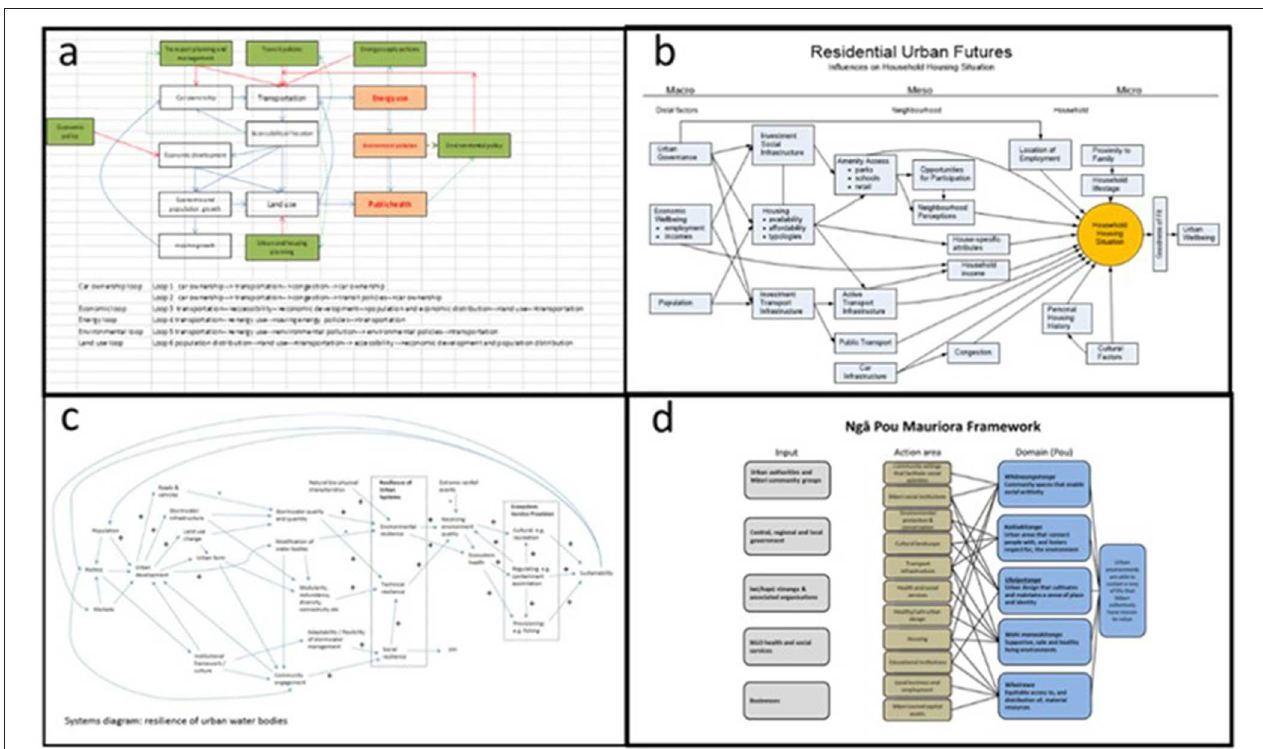
FIGURE 2 | Four examples of systems diagrams devised by members of the team to illustrate factors impacting resilience in (a) transport policy, (b) liveability, (c) urban water bodies, and (d) Maori communities.